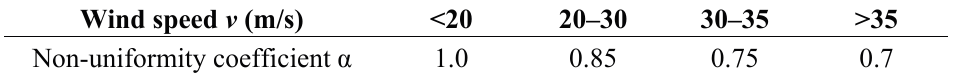
Table 1. Non-uniformity coefficient of wind speed ( α ) for 330-kV transmission lines.